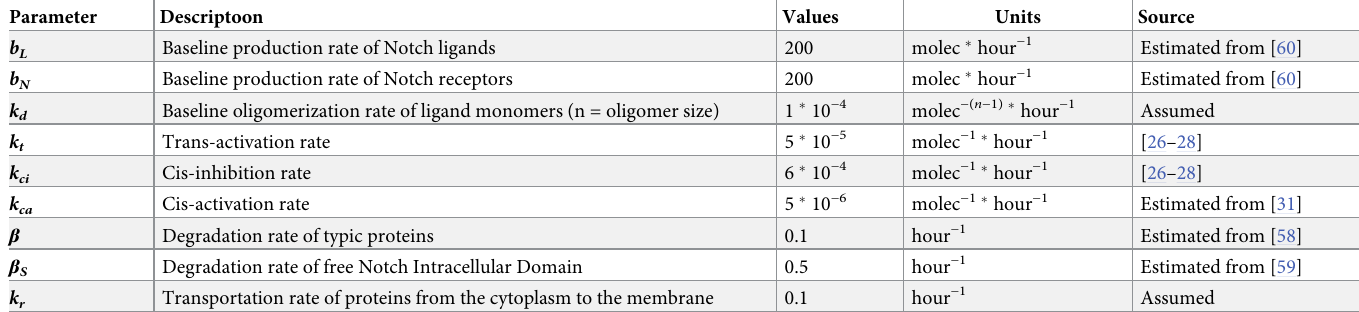
Table 1. Description and baseline values of parameters used in